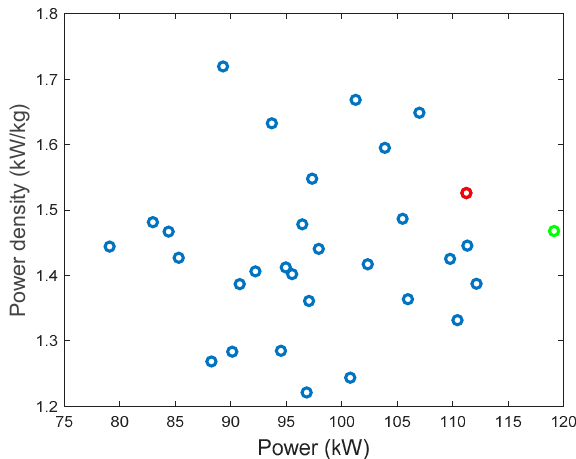
Figure 10. Initial population distribution (blue circles), final solution with best power density (red circle) and with highest rated power (green circle): ( a ) Rotor external diameter (mm); ( b ) current